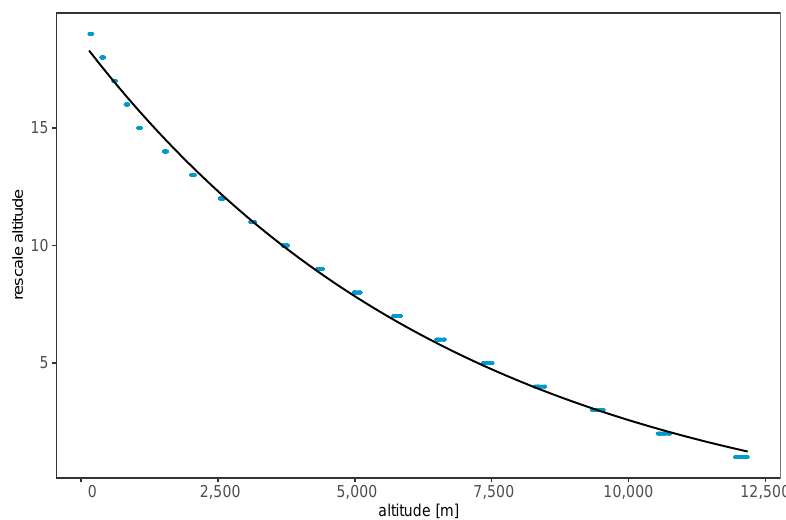
Figure 14. The scaling function for the altitude. Blue points: target GFS altitude and scaling results; black curve: the scaling function